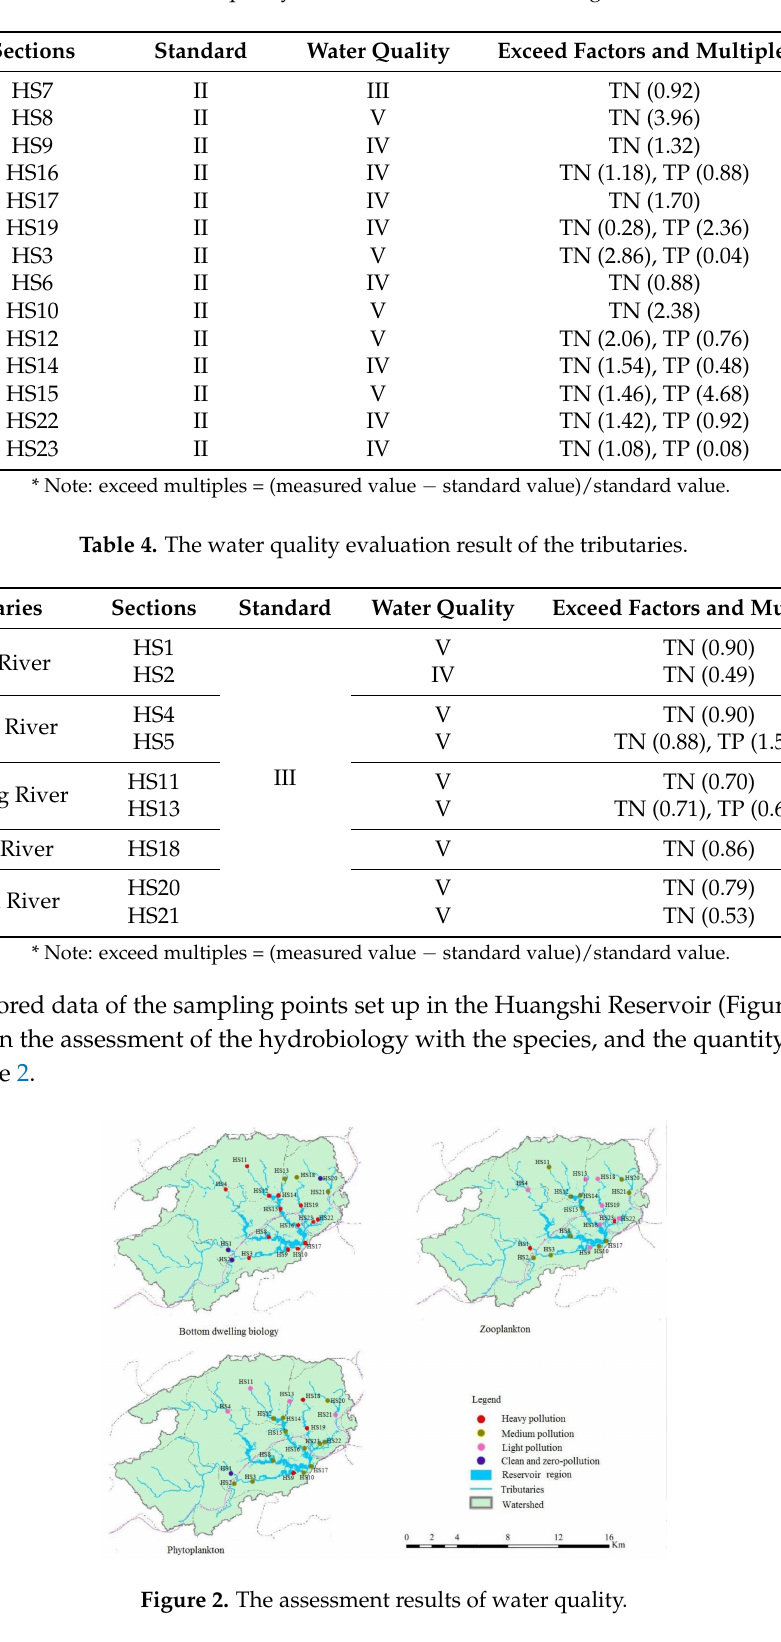
Table 3. The water quality evaluation result of the Huangshi Reservoir.